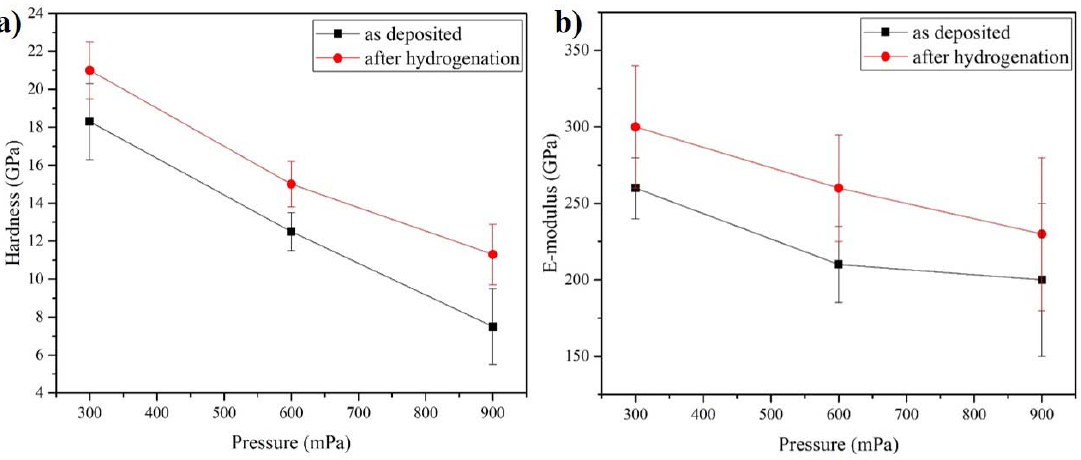
Figure 5. Mechanical properties ( a ) hardness; and ( b ) e-modulus of Cr x N coatings at various argon pressure as-deposited and after hydrogen exposure.